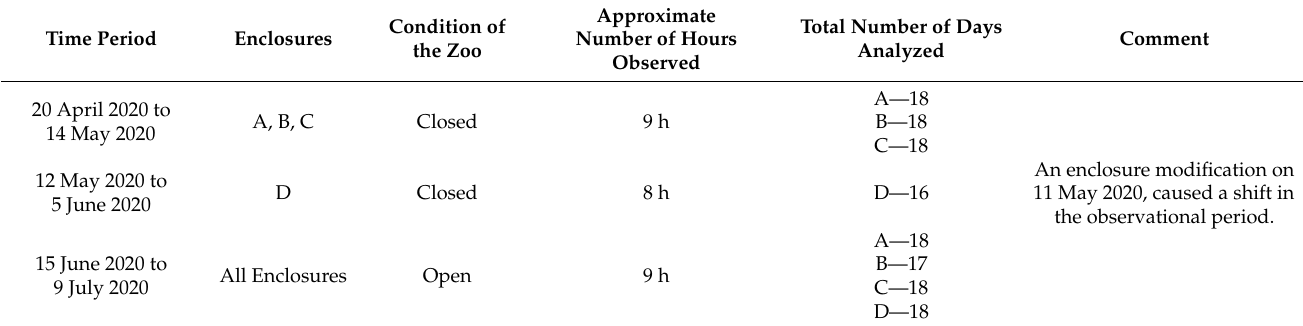
Table 3. Summary of Behavioral Observations.